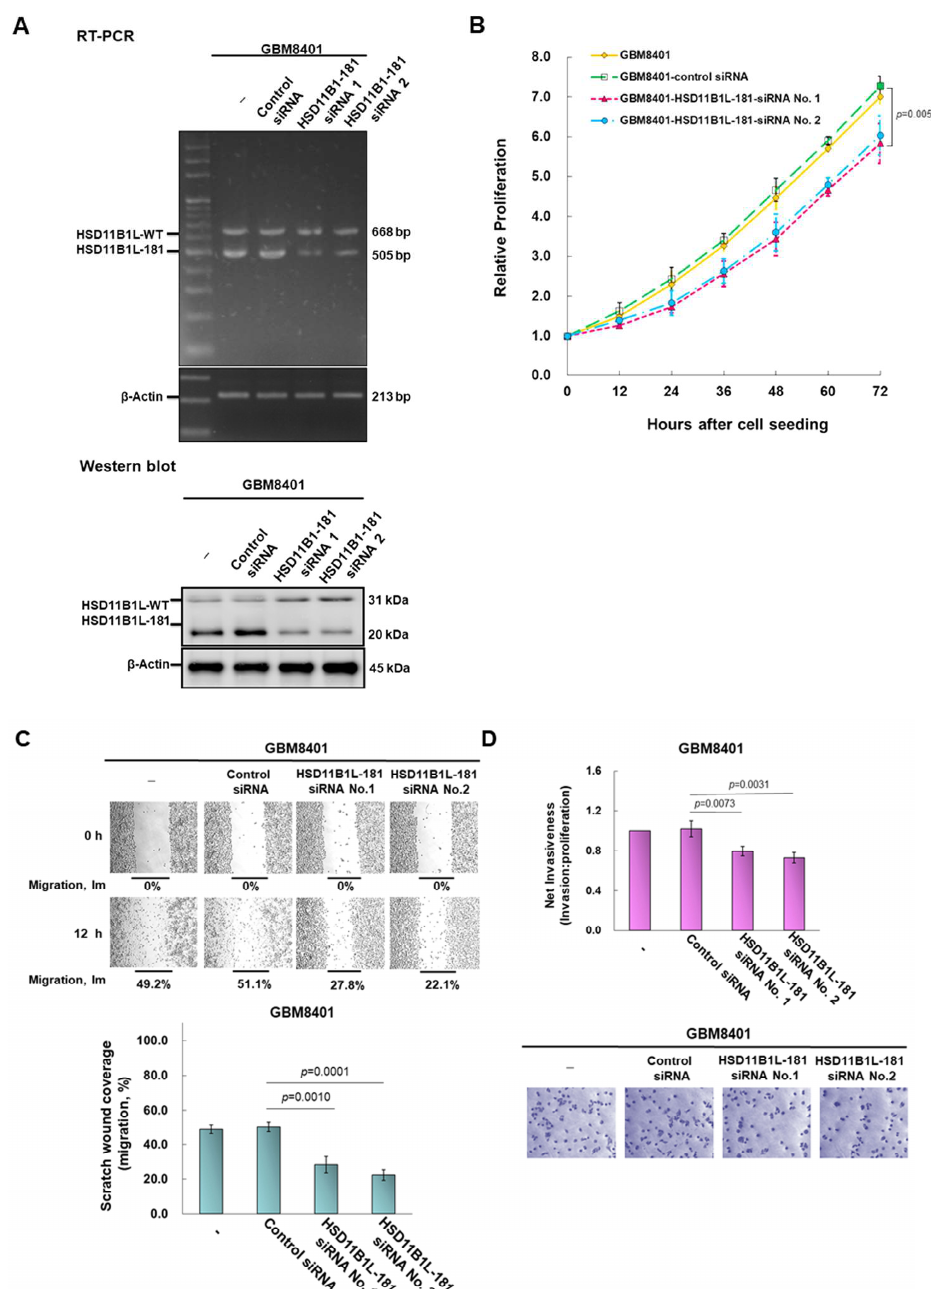
Figure 3. Down-regulating the expression of HSD11B1L-181 by siRNA can obviously reduce the proliferation, migration and invasion abilities of GBM 8401 cells. HSD11B1L-181 siRNA was transfected into GBM8401 cells and cultured for 24 h. ( A ) HSD11B1L-WT and HSD11B1L-181 expression was confirmed by RT-PCR (top) and Western blotting (bottom). The internal loading control is β -actin. ( B ) The proliferation capacity of GBM8401 cells in each group was quantified using the CellTiter Blue Cell Viability Assay. ( C ) The migratory ability of GBM8401 cells in each group was shown using a scratch test (50 × , top). Bar graphs represent quantified experimental results (bottom). ( D ) The invasive properties of GBM8401 cells in each group were determined using the InnoCyte cell invasion assay. Cells invading the basement membrane were fluorescently stained and quantified (top) or cell bodies were stained with crystal violet (100 × , bottom) 24 h after the